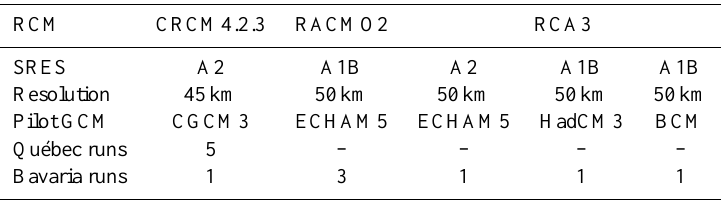
Table 1. Number of RCM simulations available per investigated region based on IPCC emissions scenario, horizontal resolution and pilot